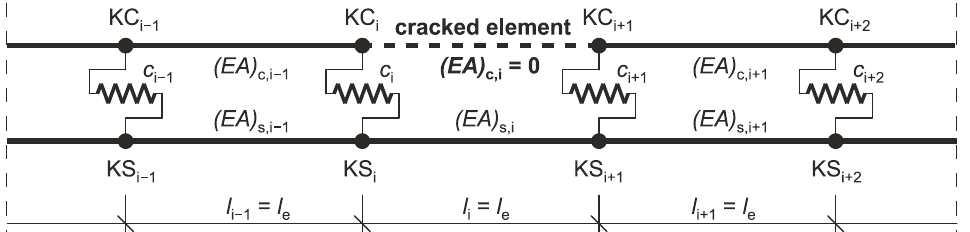
Figure 3. Cracked element in the CPM.